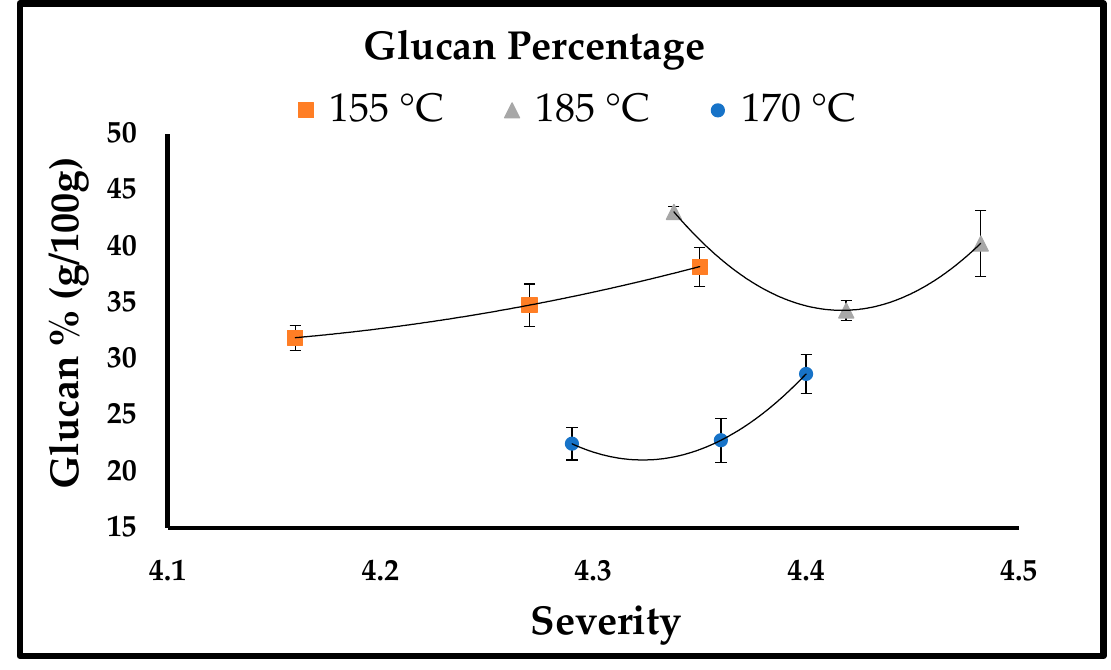
Figure 2. Glucan percentage (g/100 g).